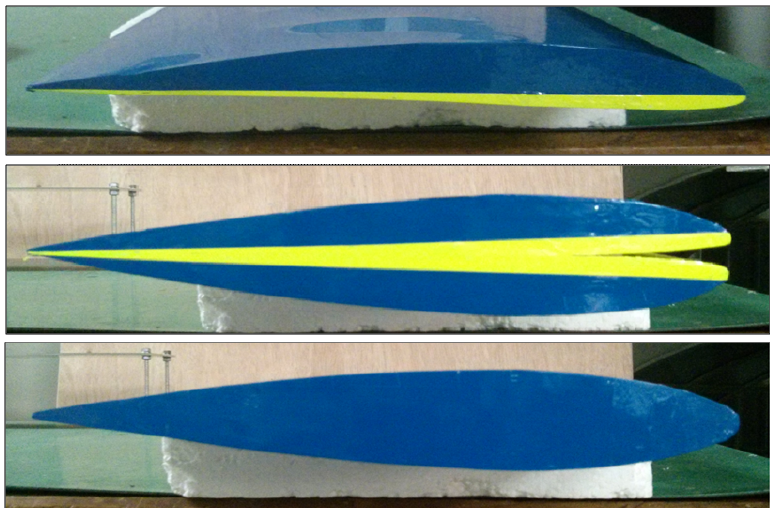
Figure 20. Models for wind tunnel testing: ClarkY 9% (top ), G2A30.7 ( middle ), G2A0.0 ( bottom